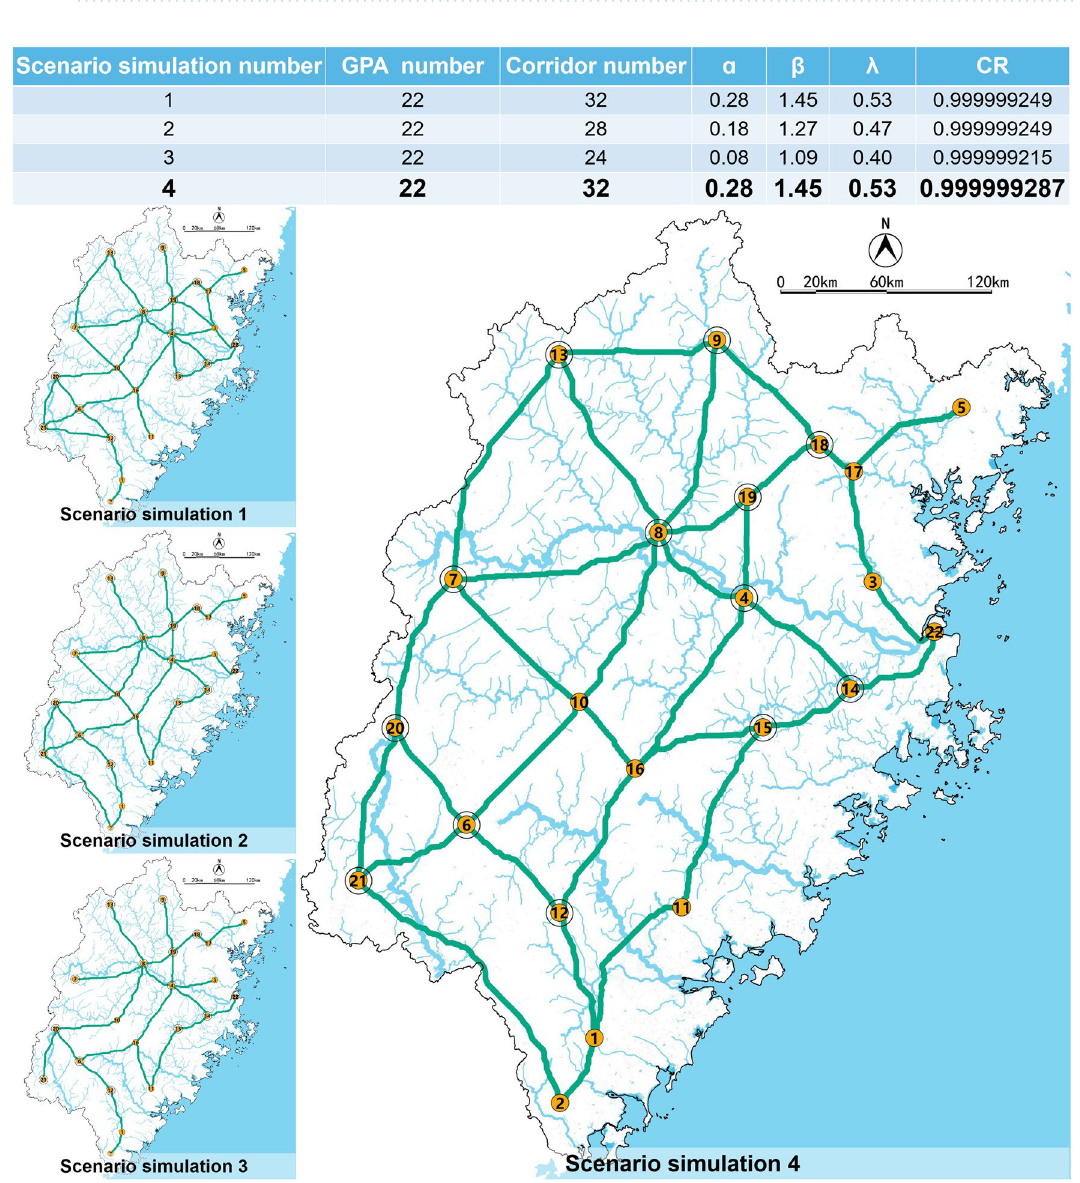
Figure 18. Network analysis results of four scenarios and ecological network of Fujian